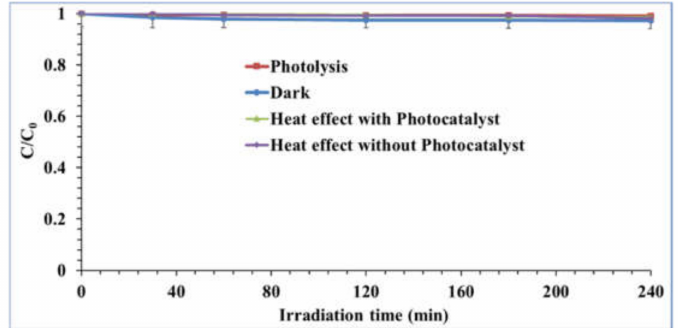
Figure 12. Photolysis effect (without catalyst), dark effect with 1 g/L Mo/SynTiO 2 , heat effect with 1 g/L Mo/SynTiO 2 , and heat effect without photocatalyst over the degradation of 5 mg/L initial CBZ concentration under natural (unmodified) pH 5.84, and 365 nm UV